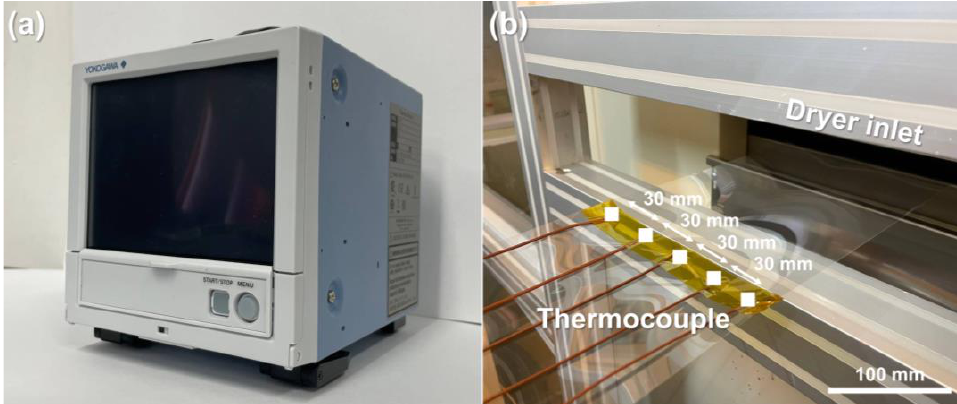
Figure 5. Web temperature measurement unit: ( a ) temperature data acquisition device; ( b ) thermo- couples equally spaced in cross-machine direction.